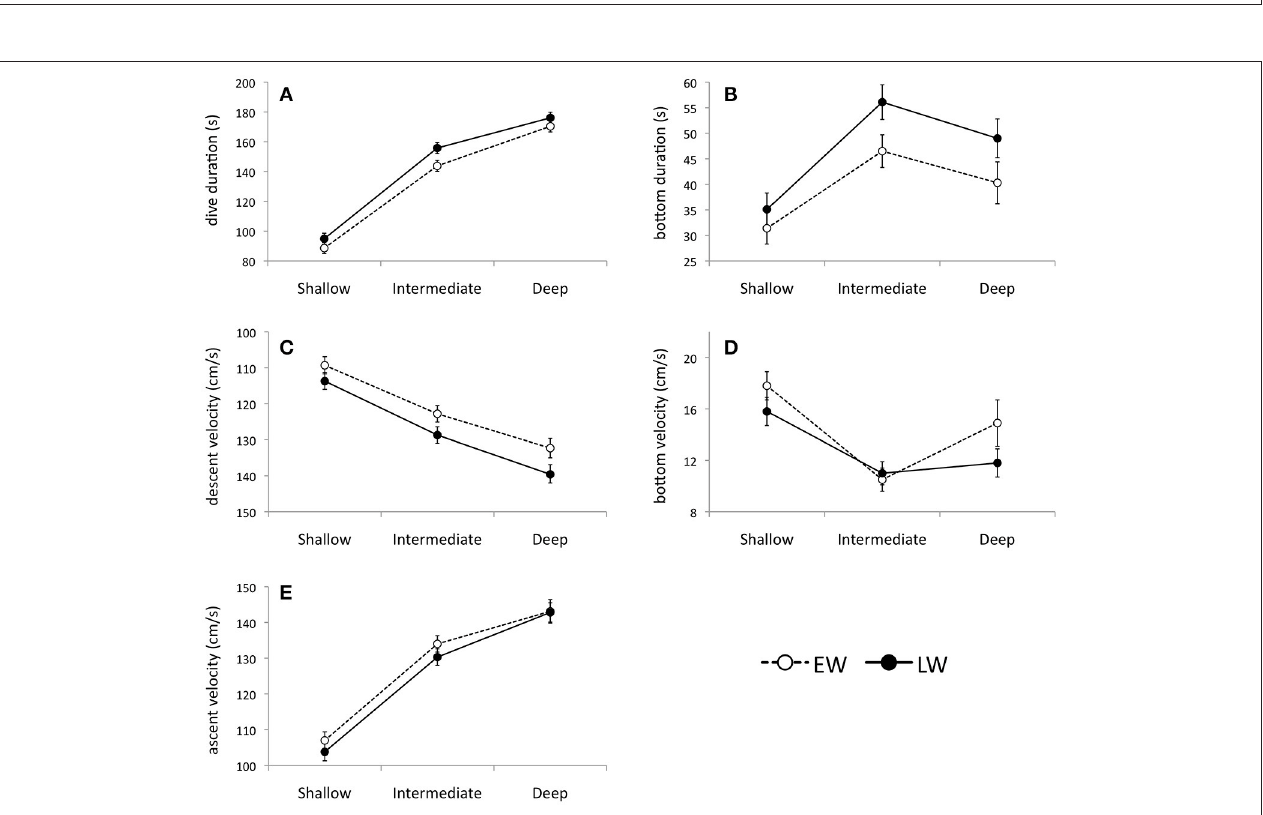
FIGURE 5 | Individual dive characteristics according to shallow (3–49m), intermediate (50–80m), and deep ( > 80m) depth intervals during early winter (EW) and late winter (LW). Parameters include: (A) dive duration ( n = 73946; dives ≥ 10 and ≤ 150m), (B) bottom duration ( n = 72108 dives; dives ≥ 10 and ≤ 150m, excludes V dives), (C) descent velocity ( n = 66370 dives; dives ≥ 30 and ≤ 150m), (D) bottom velocity ( n = 70586 dives; dives ≥ 10 and ≤ 150m, excludes V dives) and (E) ascent velocity ( n = 66352 dives; dives ≥ 30 and ≤ 150m), and (F) inter-bout pause duration ( n = 39925 bouts, pauses ≤ 1800s). Values are linear mixed model and generalized linear mixed model (where appropriate) model fits ± 95% confidence intervals where non-overlapping confidence intervals indicate significant differences. Note: due to high variability in the parameter estimates for shallow dives, dive data were truncated by depth to overcome problems with heterogeneity ( ≥ 10m, except ≥ 30m for ascent and descent